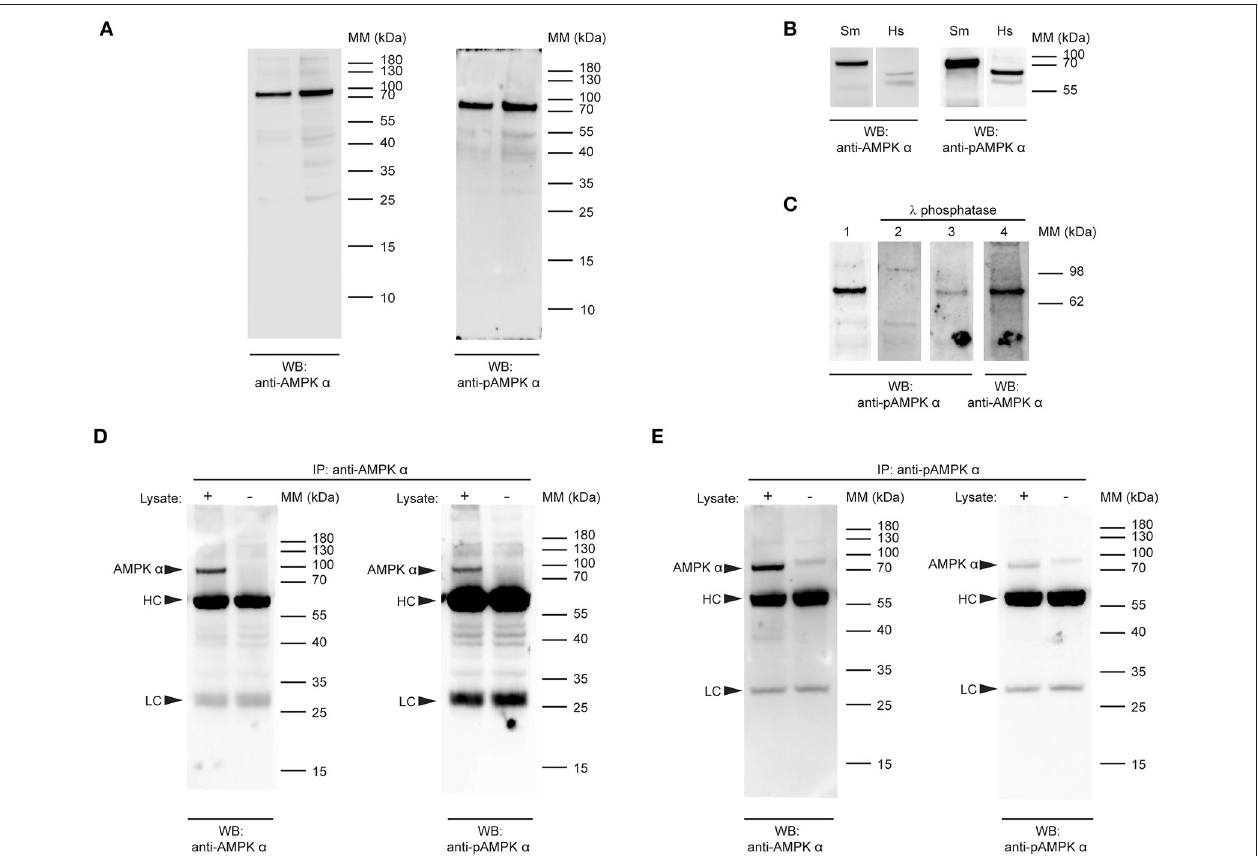
FIGURE 2 | Detection of native S.mansoni AMPK α . (A) Duplicate samples of adult S. mansoni worm lysate were probed by Western blot with a polyclonal antibody raised against the catalytic domain of human AMPK α -1/2 (anti-AMPK α , RRID AB_2553341, left panel) and a phospho-specific monoclonal antibody that recognizes human AMPK α -1/2 when phosphorylated at Thr183/Thr172 (anti-pAMPK α , clone 40H9, right panel). (B) Lysates of adult S.mansoni worms (Sm) and human embryonic kidney cells (Hs), probed with anti-AMPK α (AB_2553341, left panel) and anti-pAMPK α (clone 40H9, right panel). (C) PVDF membranes bearing 10 µ g adult S. mansoni worm lysate were probed with anti-pAMPK α (clone 40H9) either before (lane 1) or after treatment with λ protein phosphatase (lane 2). Lanes 3 and 4 are the same membrane as in lane 1, reprobed with anti-pAMPK α (lane 3) or anti-AMPK α (lane 4) after treatment with λ phosphatase. (D,E) AMPK α protein was immunoprecipitated from adult schistosome lysates using either anti-AMPK α (D) or anti-pAMPK α (E) . The immunoprecipitates were then probed by Western blot with anti-AMPK α (left panel) and anti-pAMPK α (right panel). Control immunoprecipitates where the lysate was omitted were also included. Arrowheads indicate the position of the schistosome AMPK α (AMPK α ) and the immunoglobulin heavy chain (HC) and light chain (LC) of the immunoprecipitating antibody. WB, indicates the antibody used for Western blotting; IP, indicates the antibody used for immunoprecipitation; Positions of molecular mass (MM) markers, in kilodaltons (kDa), are indicated to the right of each